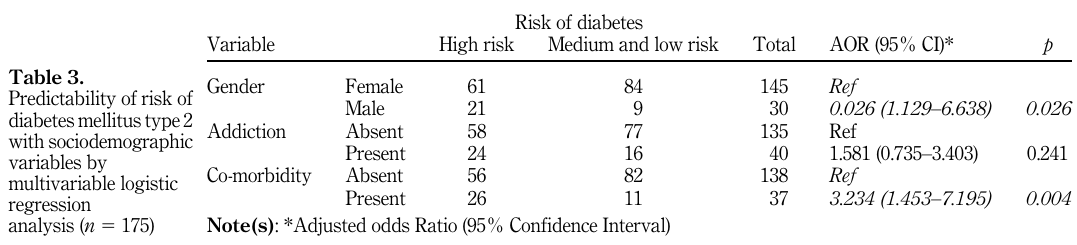
Table 3. Predictability of risk of diabetesmellitustype2 with sociodemographic variables by multivariable logistic regression analysis ( n 5